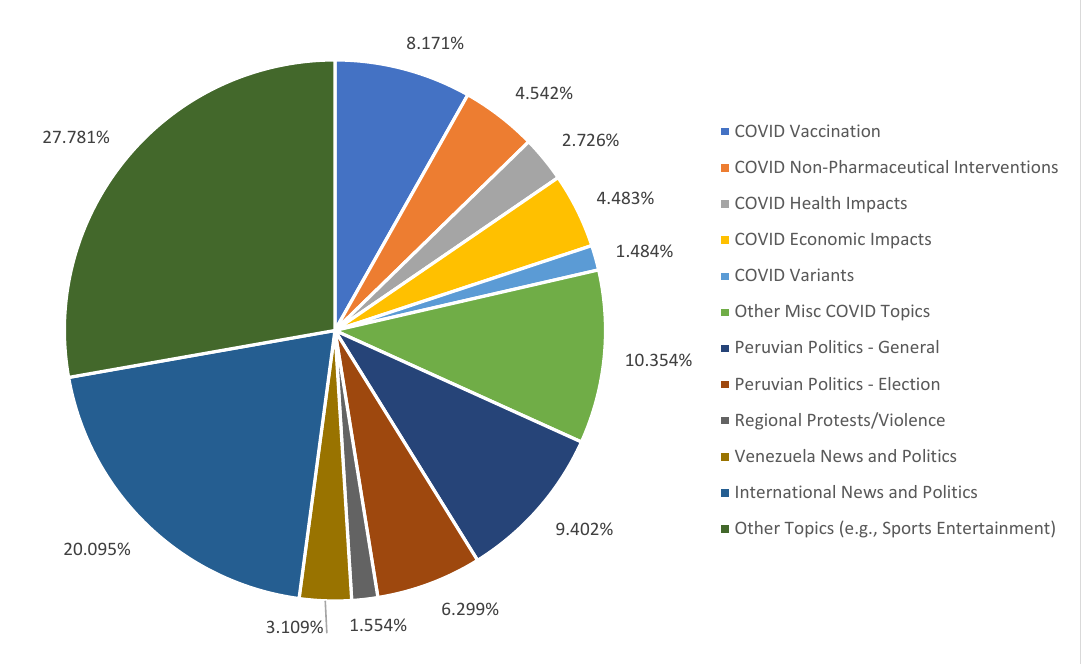
Figure 1. Topic clusters distribution.